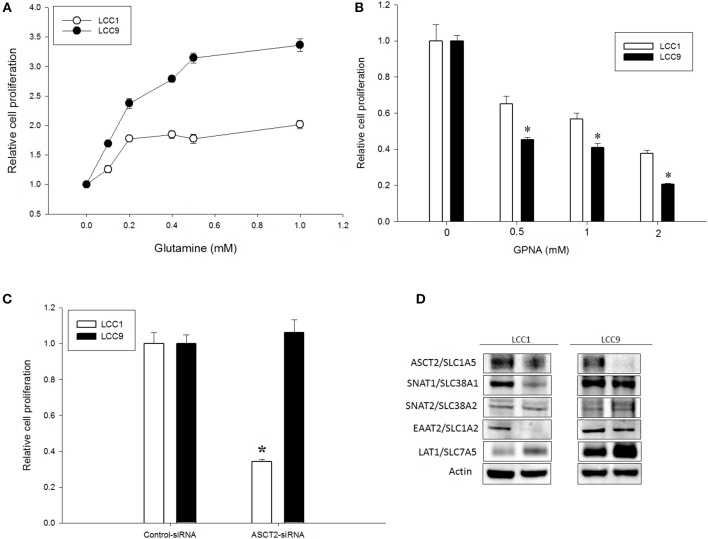
Glutamine dependency is increased but ASCT2 is dispensable in antiestrogen resistant breast cancer cells. (A) Glutamine significantly (ANOVA, p < 0.01) increased cell proliferation in LCC9 cell compared with LCC1 cells in a dose-dependent manner. Changes in cell proliferation were determined by normalizing cell number measurements at different doses to 0 mM glutamine (vehicle was water). (B) LCC9 cells were significantly more sensitive to L-γ-Glutamyl-p-nitroanilide (GPNA), an inhibitor of ASCT2 (SLC1A5) and other sodium-dependent amino acid transporters. Bars represent the mean ± SE of relative number (normalized to vehicle control) for a single representative experiment performed in sextuplicate. All experiments were repeated three times. ANOVA, p < 0.001; *p < 0.05 for LCC9 vs. LCC1 for indicated concentrations. (C) Knockdown of ASCT2 levels with siRNA in LCC1 cells showed significant decrease in cell number at 72 h compared with that in LCC9 cells. ANOVA, p = 0.05; *p ≤ 0.01 for LCC1 ASCT2-siRNA compared with LCC1 control-siRNA. (D) Western blotting showed decreased levels of ASCT2 protein in both cell lines following knockdown with ASCT2-siRNA. In LCC1 cells, protein levels of SNAT1 and EAAT2 were decreased while LAT1 was increased with ASCT2 knockdown. In LCC9 cells, SNAT1 and EAAT2 levels were unchanged while LAT1 levels were increased with ASCT2 knockdown; actin was used as a protein loading control.